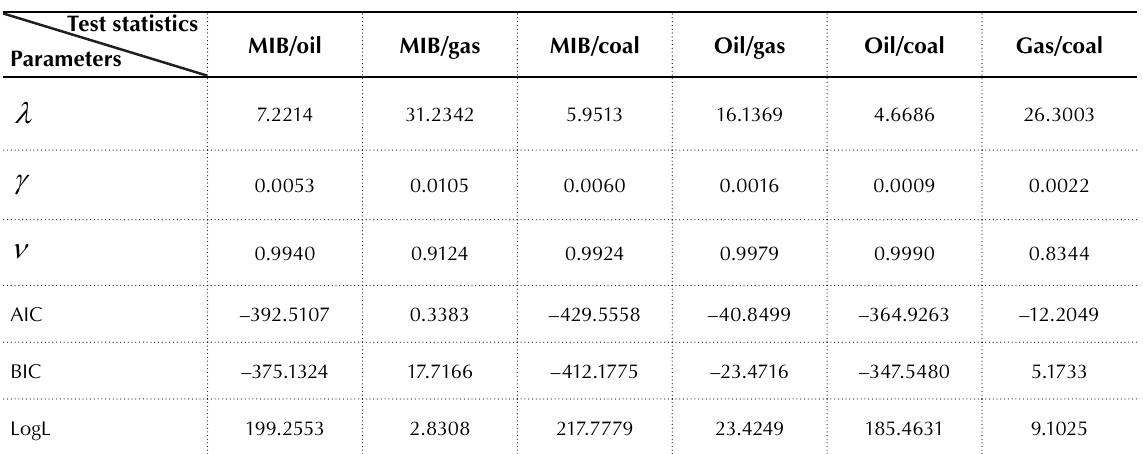
Table 4. T -copula and DCC parameters for each pair of returns